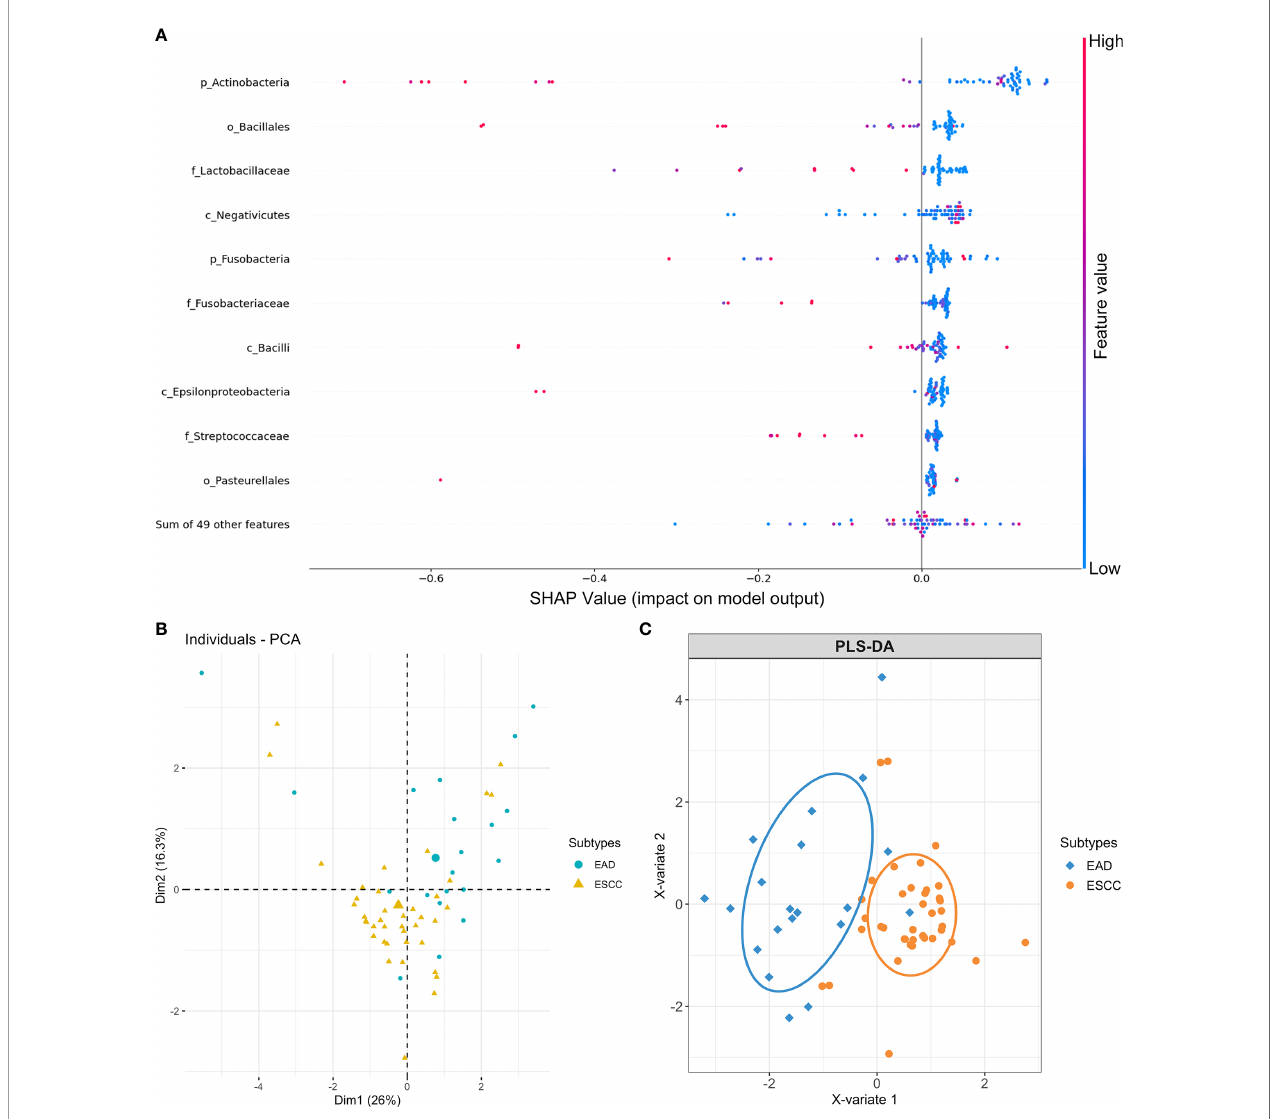
FIGURE 3 | Microbial feature selection in predicting different cancer subtypes of esophageal carcinoma. (A) Summary plots of the importance values of the top 10 predictable microbes. (B) PCA plots and (C) PLS-DA plots based on the top 10 microbial features display the EAD and ESCC subtypes of esophageal